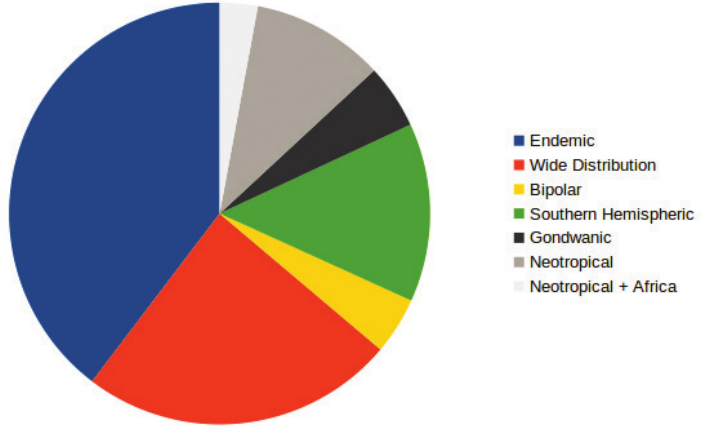
Figure 2. Proportion of the biogeographic components in the total moss flora of Bío-Bío